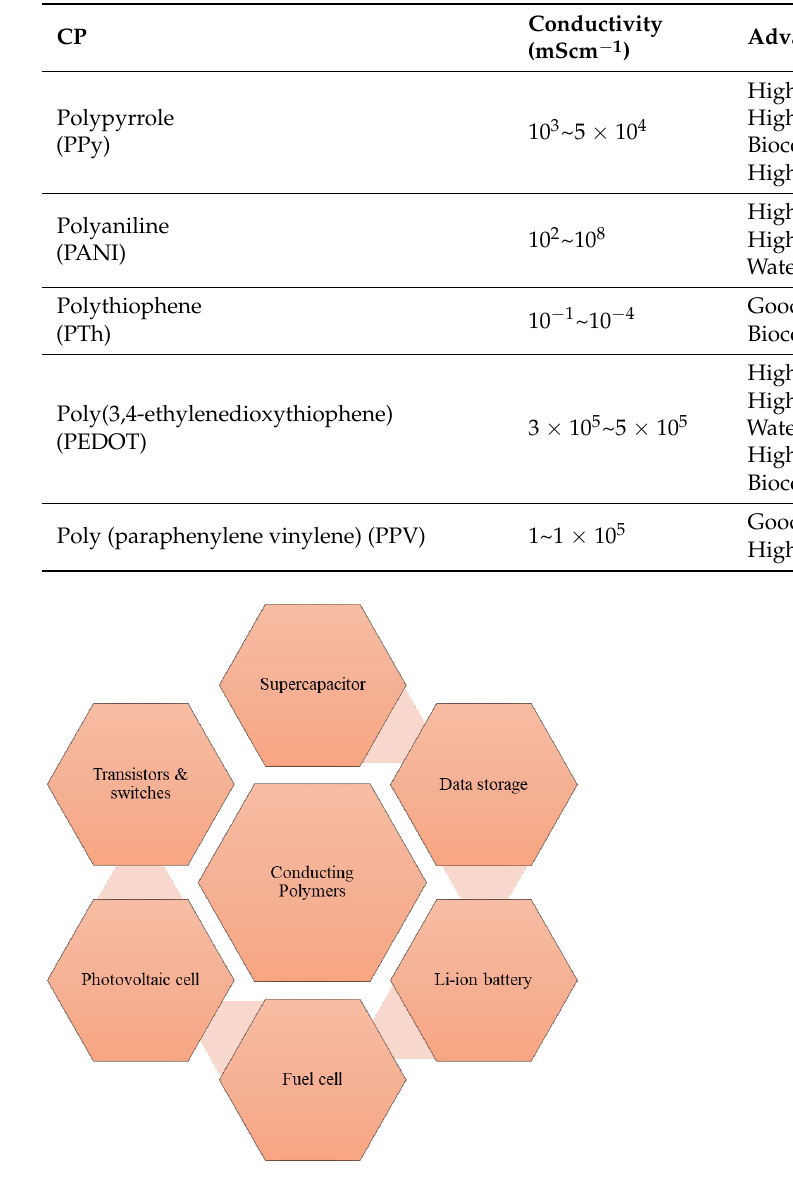
Table 1. Bulk properties of some most common conducting polymers.